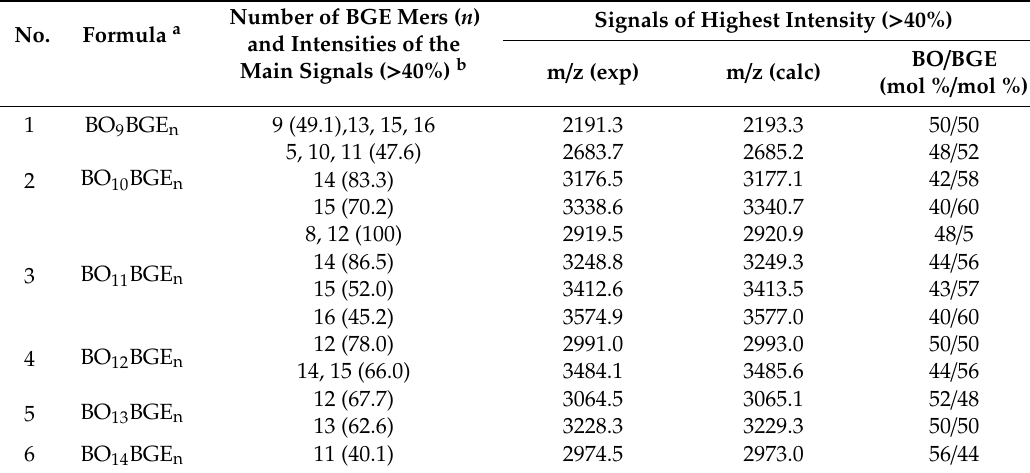
Table 8. Composition of BO/BGE random copolyether-diol (21) determined by MALDI-TOF mass spectrometry. Composition of BO / BGE random copolyether-diol (21) determined by MALDI-TOF mass spectrometry.